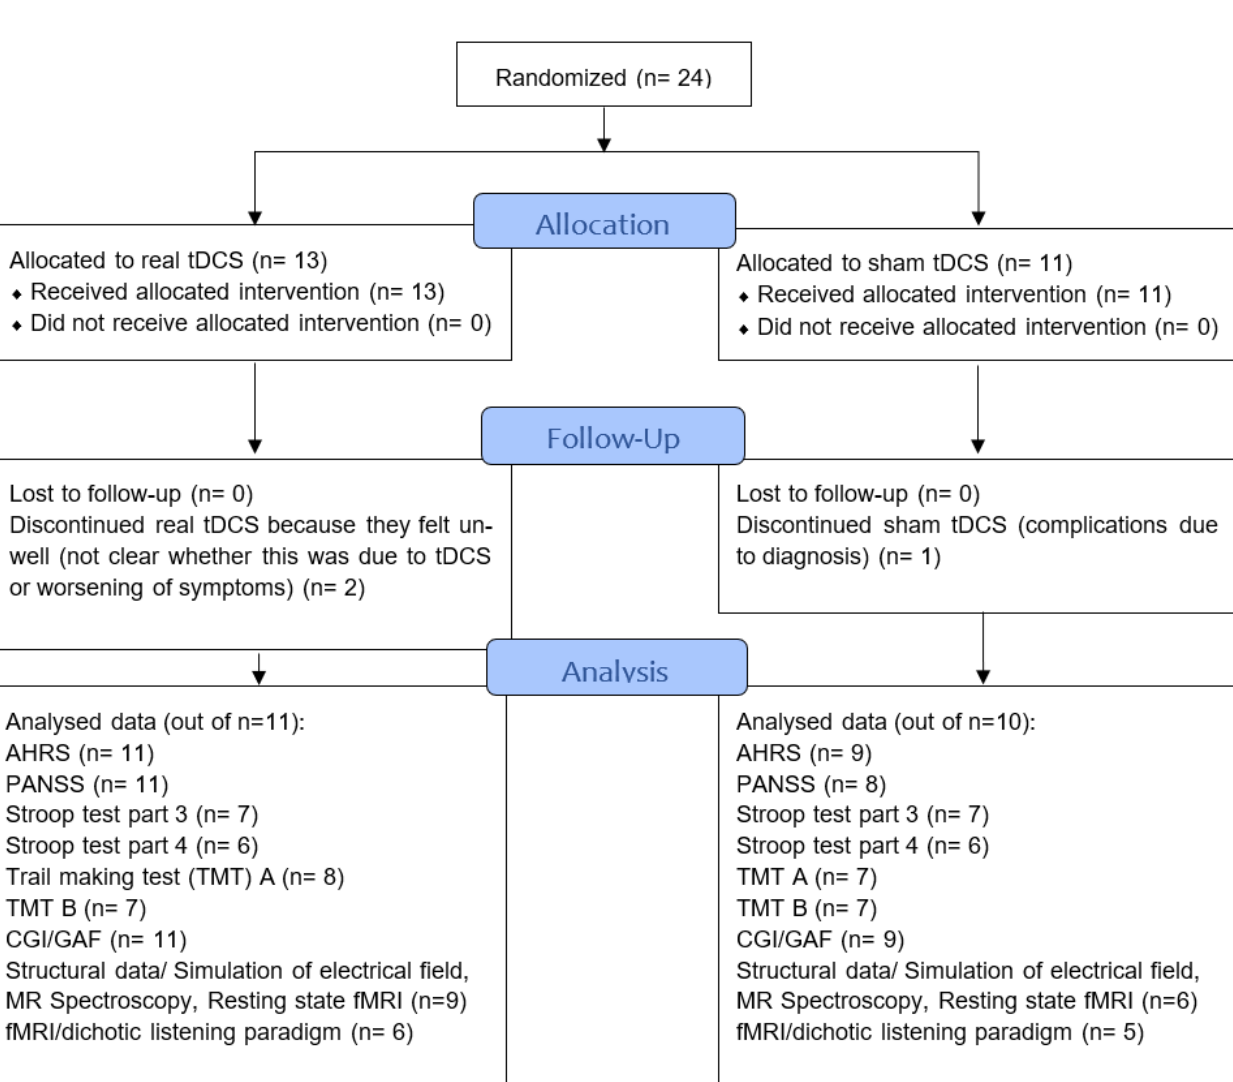
Figure 1. CONSORT flowchart of the study showing sample sizes throughout study, follow-up and analysis. AHRS — Auditory Hallucination Rating Scale, PANSS — Positive and negative syndrome scale, CGI — Clinical Global Impression. GAF — Global Assessment of Functioning, Stroop — Stroop test, TMT — Trail Making Test, fMRI — functional magnetic resonance imaging.